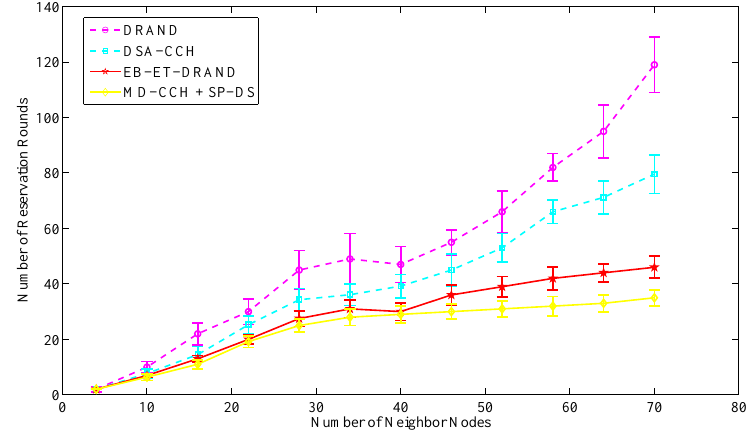
Figure 15. The average number of reservation rounds for successful allocating a time slot in different size of neighbor